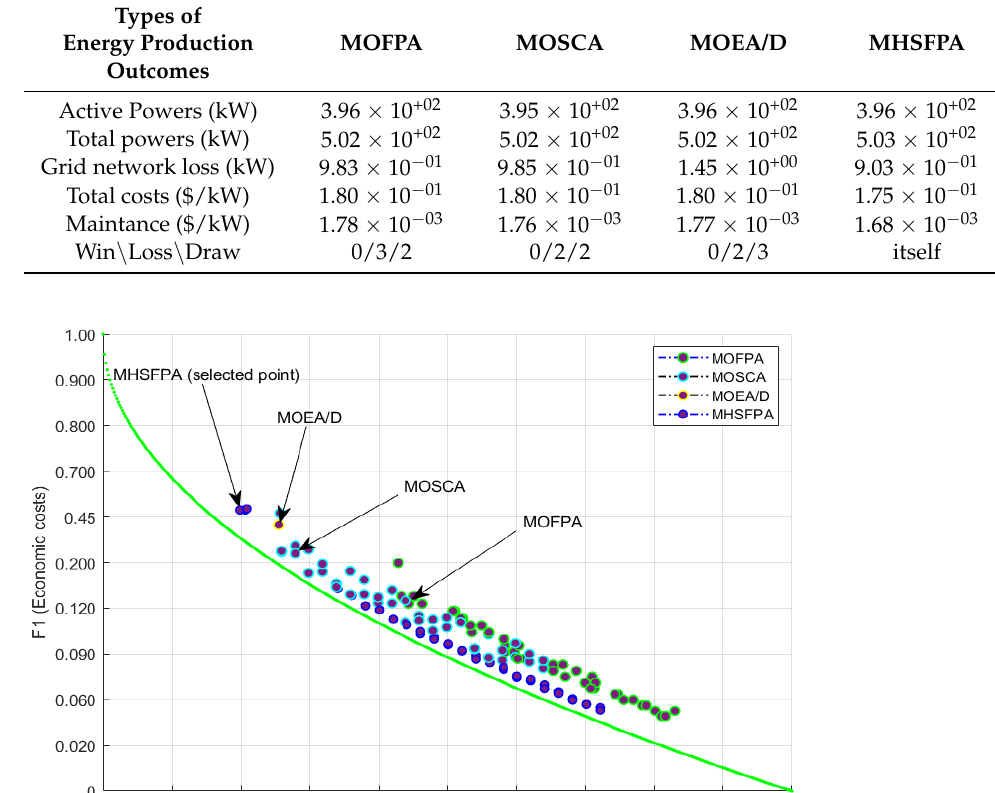
Figure 7. The obtained result curves of the multiobjective optimal dispatching with Pareto optimal front in MHSFPA, MOSCA, MOFPA, and MOEA/D algorithms.